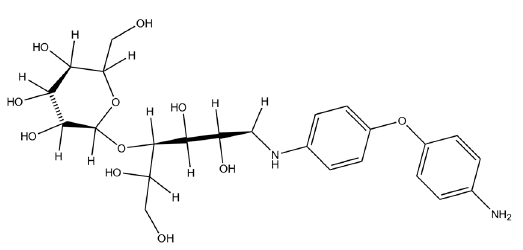
Figure 1. Molecular structure of the synthesized sugar ligand LODAN.